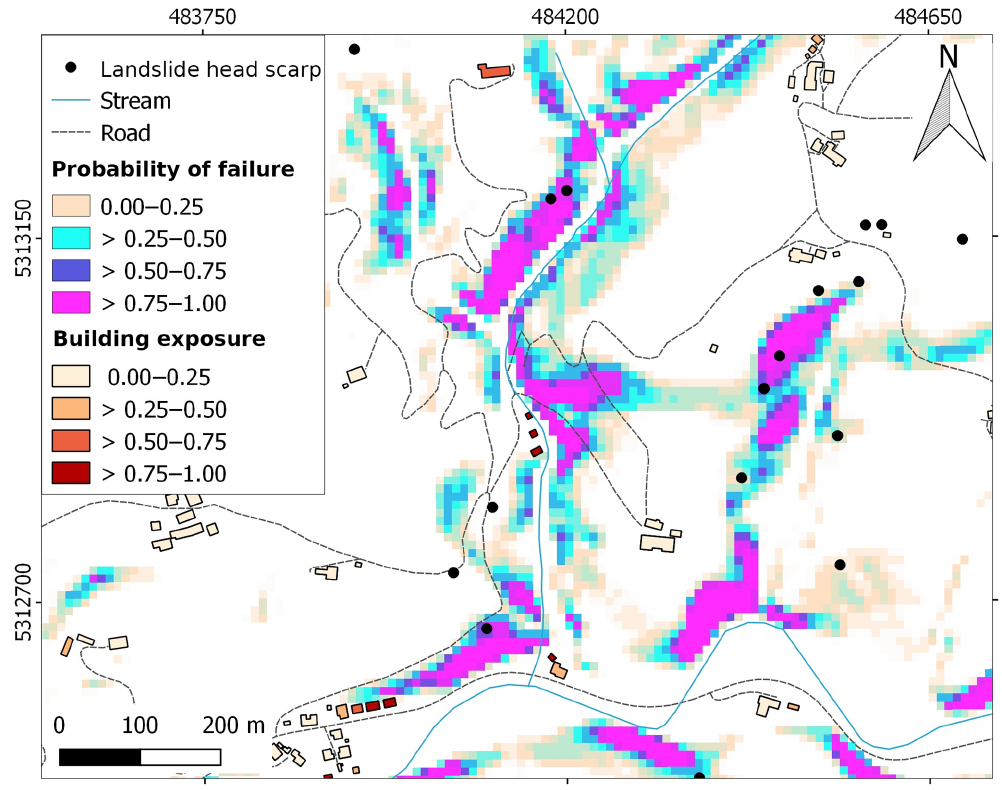
Figure 5. Probability of failure map detail for a specific rainfall event. Known historic landslide initiation points (black dots) partly overlap with current slope stability conditions. However, high spatial resolution, and therefore a high degree of spatial discontinuity, poses a risk for missing many real landslide events in an early warning